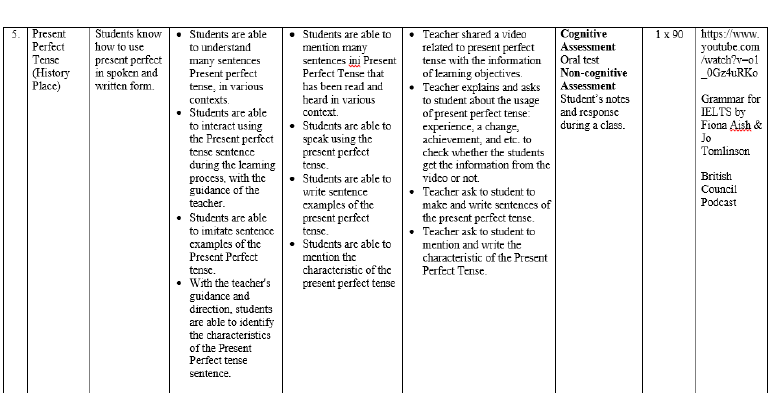
Figure 3: Syllabus of One of the Past Tense Meetings